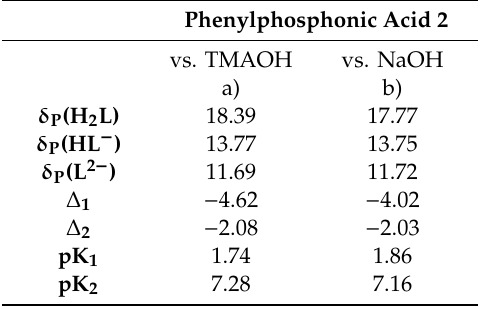
Table 3. Specific chemical shifts δ P [ppm], gradients [ppm] and dissociation constants pK i from 31 P{ 1 H}-NMR-controlled titration of phenylphosphonic acid 2 vs. TMAOH and NaOH. Exp.: C